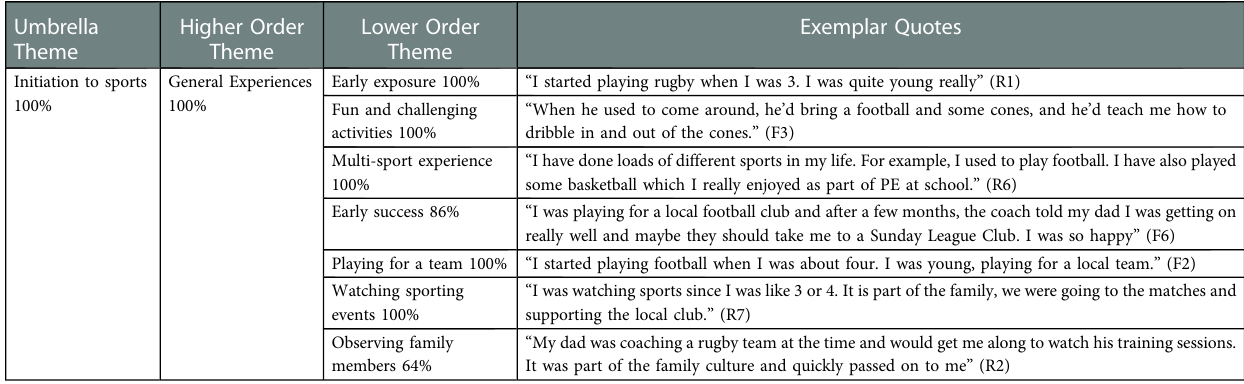
TABLE 3 Nature of general experiences as part of early involvement with sport s. Umbrella Theme